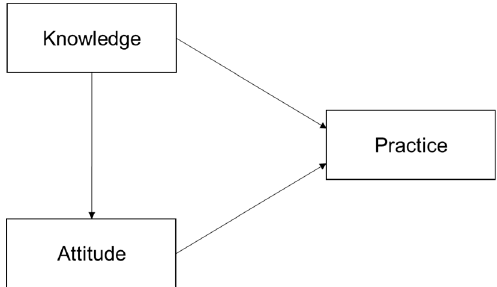
Figure 1. Conceptual model of knowledge, attitude and practice.